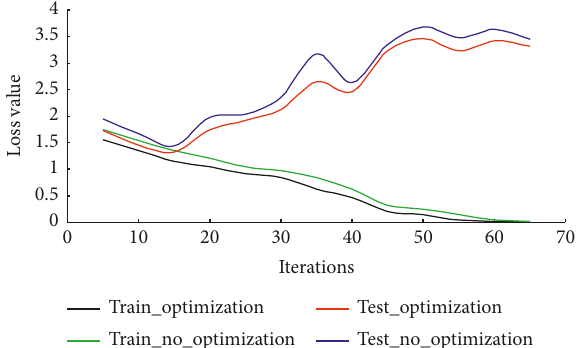
Figure 14: Iterative comparison of model loss value before and after